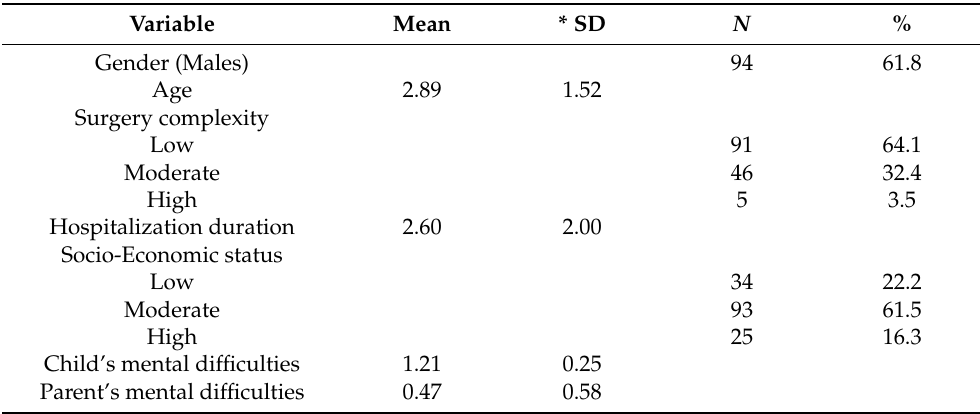
Table 1. Demographic and clinical background characteristics of the